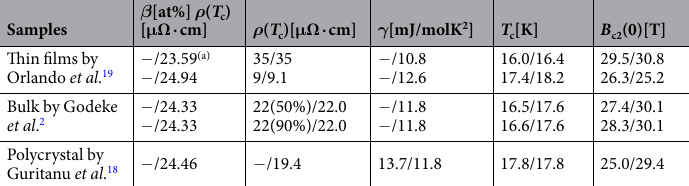
Table 2. Calculated H-T phase boundary and comparison to experiments. (a) Before the oblique line is the experimental value and after that presents the calculated